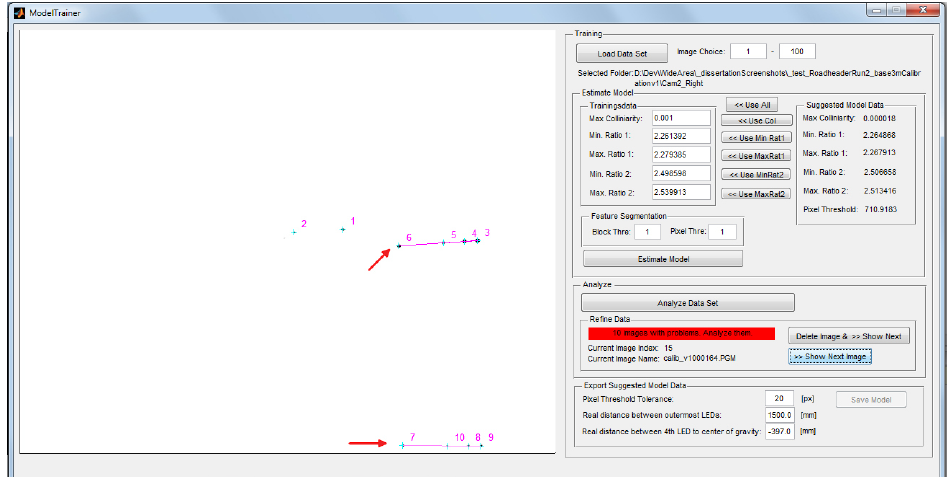
Figure 17. User interface of semi-autonomous Model